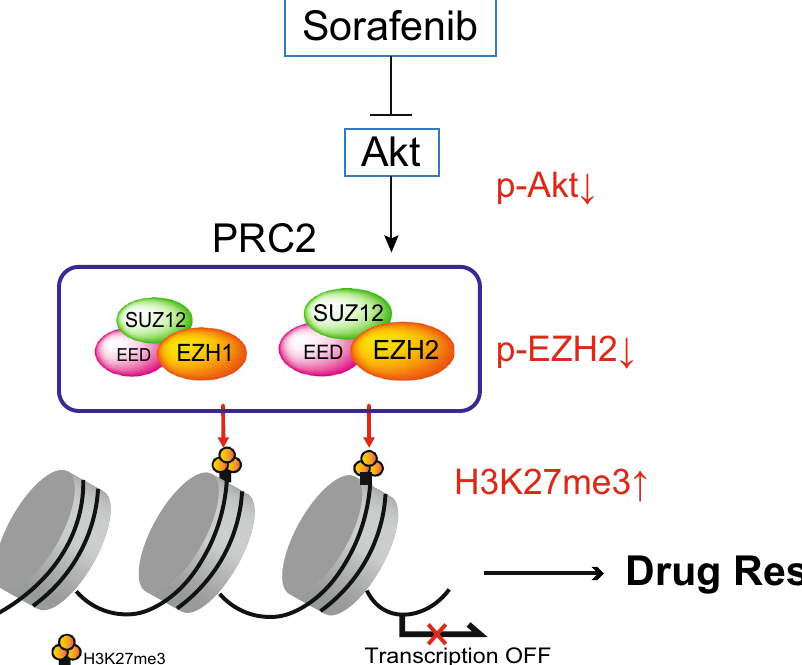
Figure 7. A proposed model for the effect of the combined use of sorafenib and EZH1/2 inhibitors, in terms of H3K27me3 level